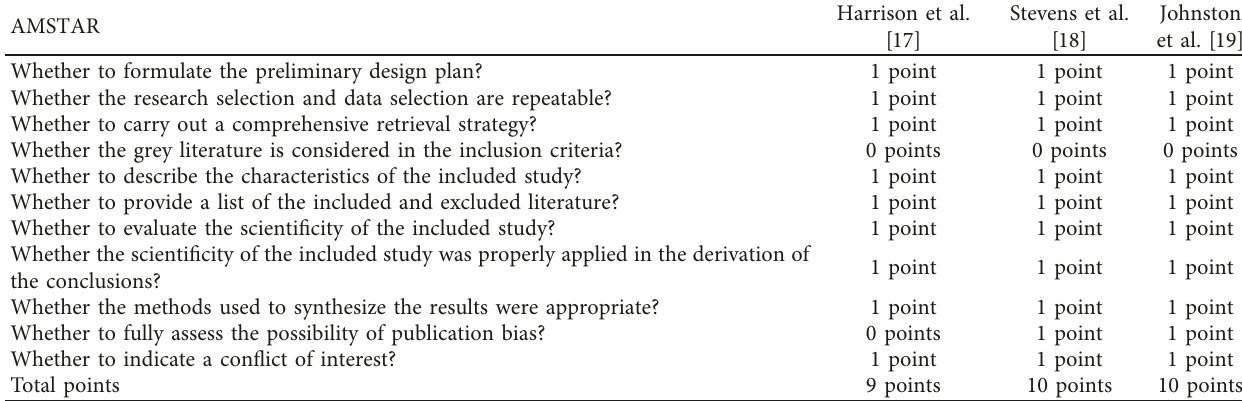
Table 3: Quality evaluation of systematic